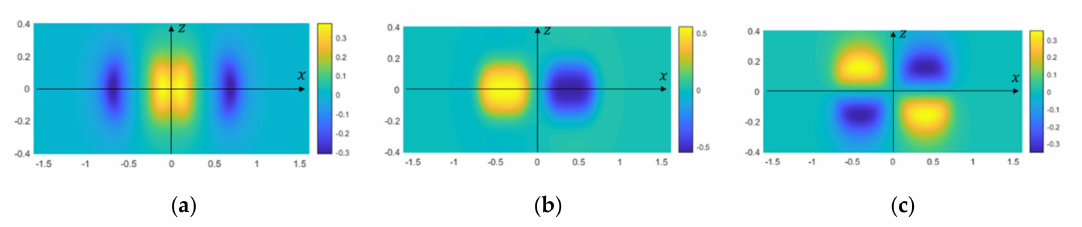
Figure 6. The superconducting magnet (SCM) with a 300 kAt magnetomotive force (MMF) that consists of a pair of N and S poles forms MFD at a 65-mm air gap as ( a ) B x ( b ) B y , and ( c ) B z